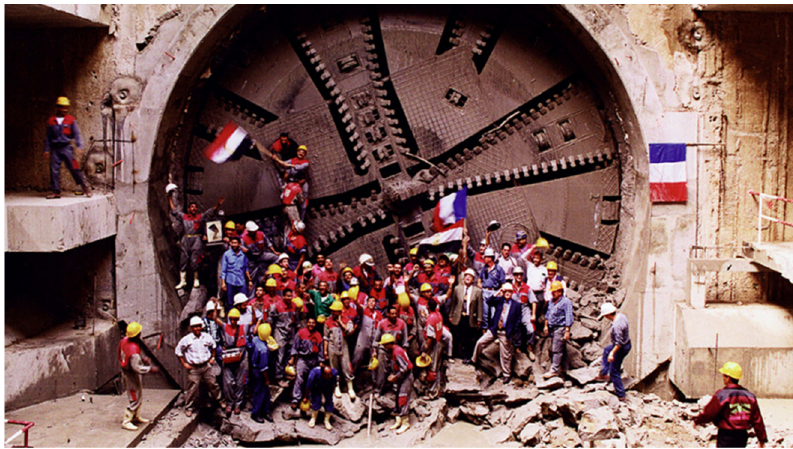
Figure 2. Tunnel profile. ( a ) plan view, ( b ) elevation section.